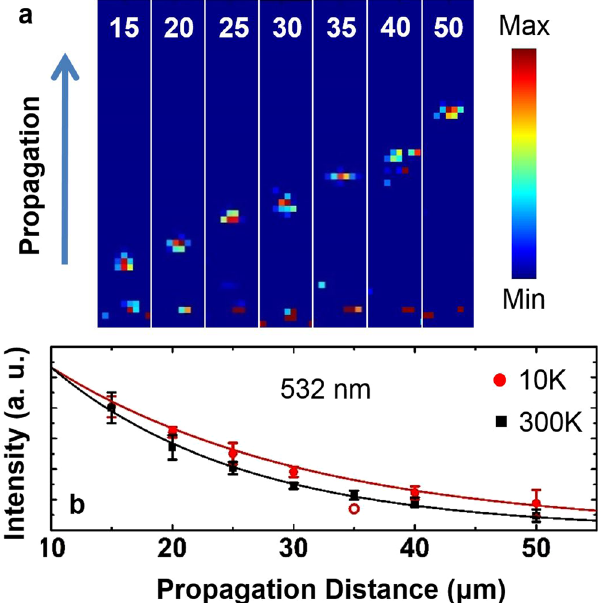
Figure 2. Extraction of propagation distance at 300K with incident light at 532 nm. ( a ) Intensity images captured by CCD. ( b ) Integrated output intensity as a function of distance. Solid black squares and solid red circles are experimental data from 300K and 10 K, respectively. Solid lines are exponential fits. Open red circle is a data point discarded in the fitting due to a small surface crack appeared between that particular groove pair during sample